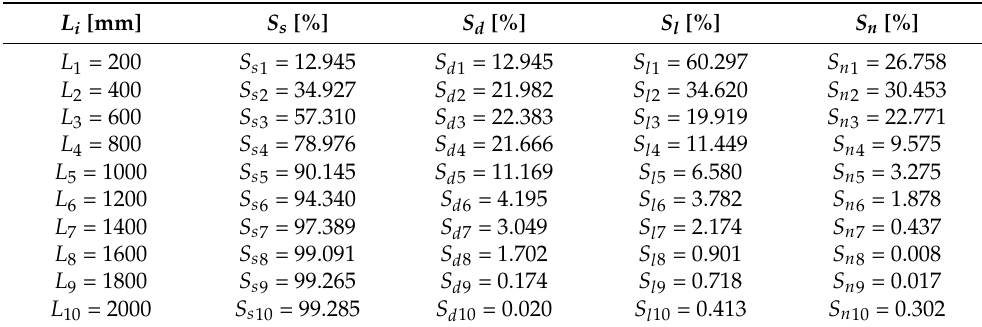
Table 3. The variation in the percentage of separated seeds, free seeds, distribution density, and unthreshed seeds along the threshing length of the axial apparatus.